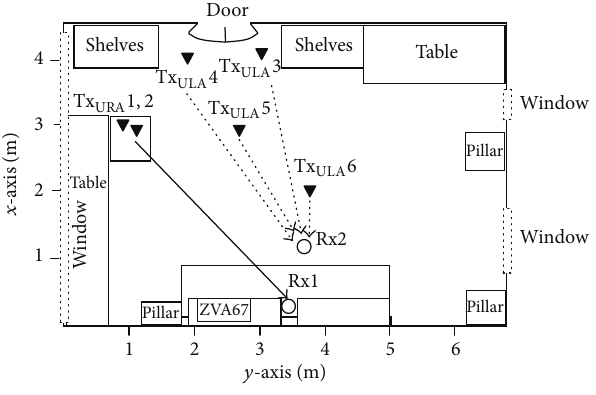
Figure 1: Map of